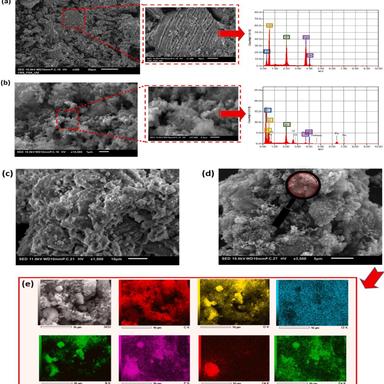
SEM/EDS analysis of Bio-HAp and Bio-HAp@PPy nanocomposite before adsorption (a, b) and after adsorption (c, d), with EDS mapping for Bio-HAp@PPy nanocomposite after adsorption (e).